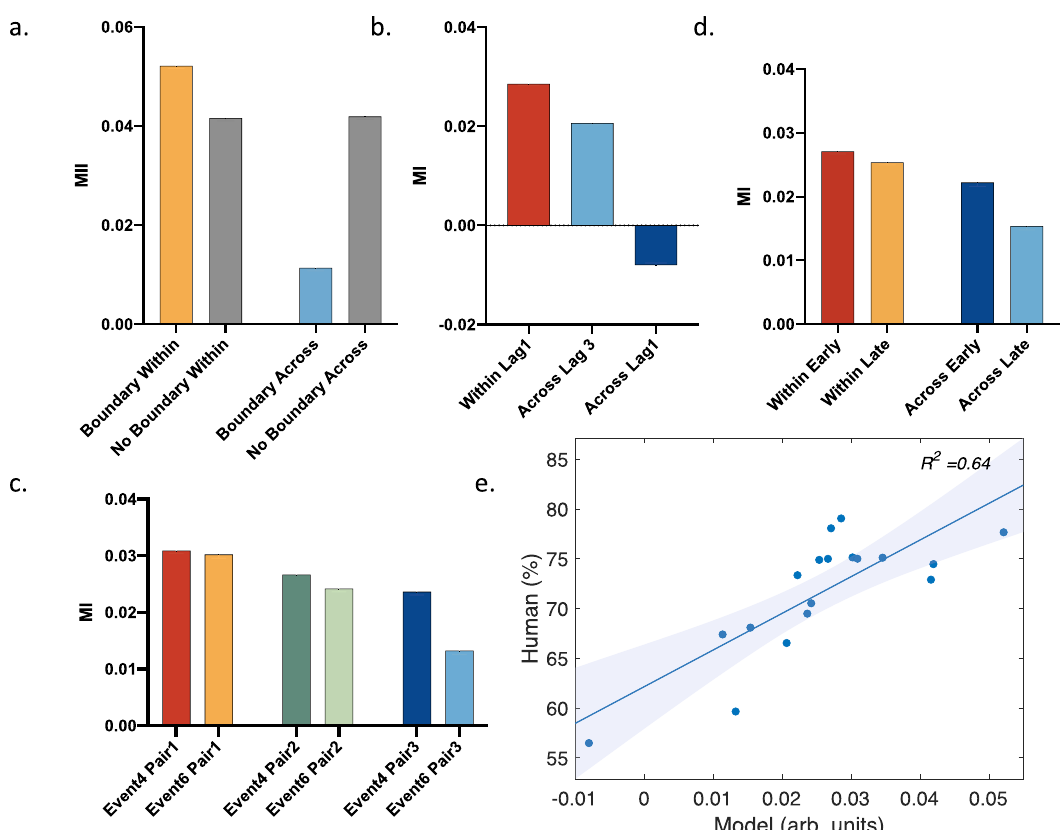
Fig. 5 Model results. a – d . Model outputs as quanti fi ed by our memory index (MI, i.e., d2-d1 as shown in Fig. 4d.) for Experiments 1-4, when the drift rate and reset rate were set at p = 0.02 and λ = 0.2. e Pearson correlation between model outputs shown in Fig. 5a – d and the corresponding group averaged behavioural results pooled together across behavioural experiments. The shaded area represents 95% con fi dence interval of the regression line. arb. units refers to arbitrary units. Source data are provided as a Source Data fi